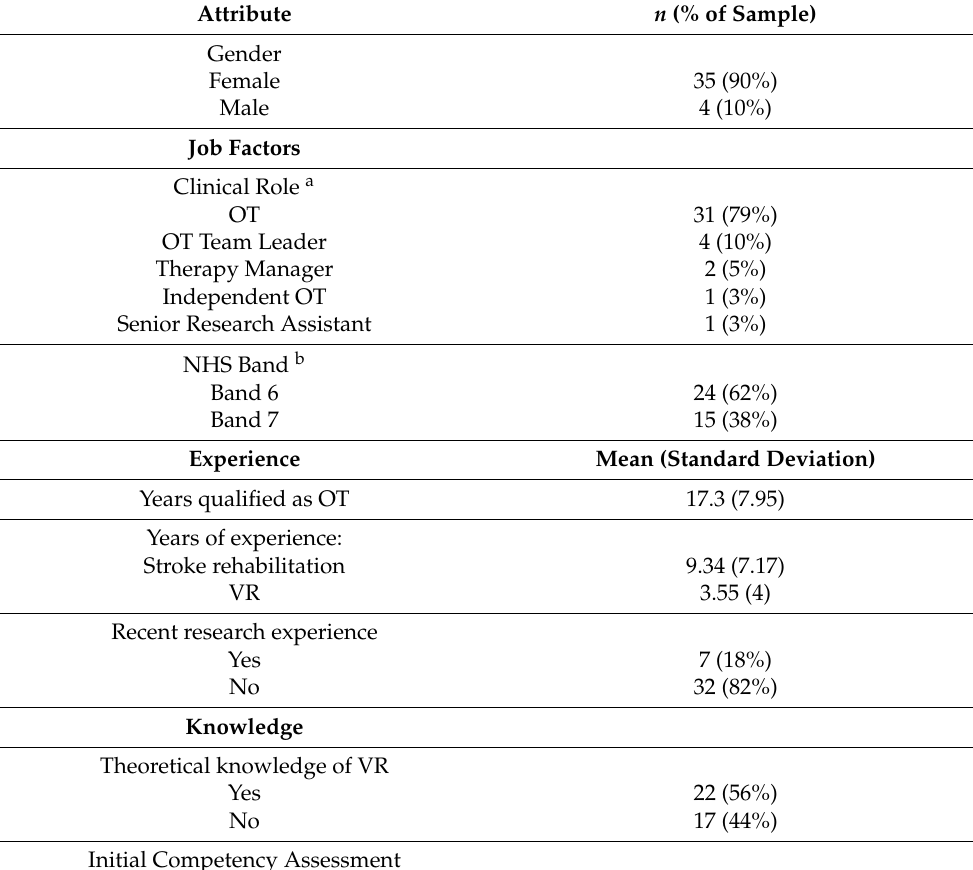
Table 2. Attributes of the 39 OTs delivering